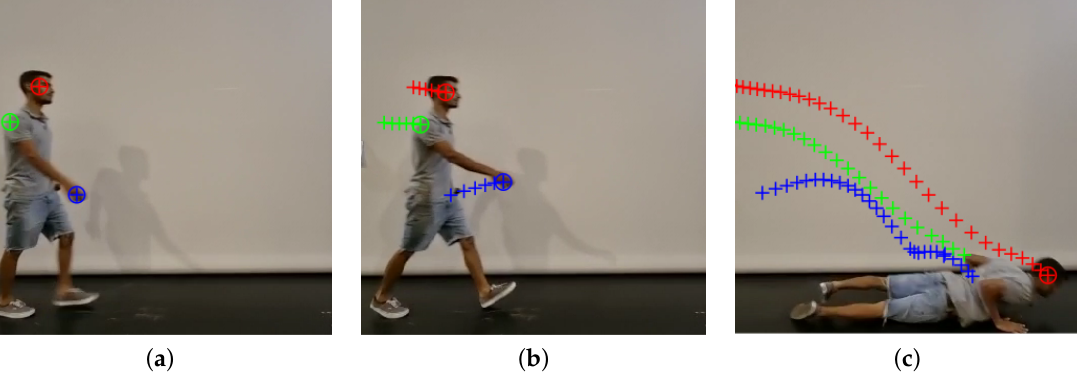
Figure 13. Video analysis process of a man falling while walking, tracking motion of the head (red markers), shoulder (green markers) and right hand (blue markers) ( a ) at the beginning of walking;